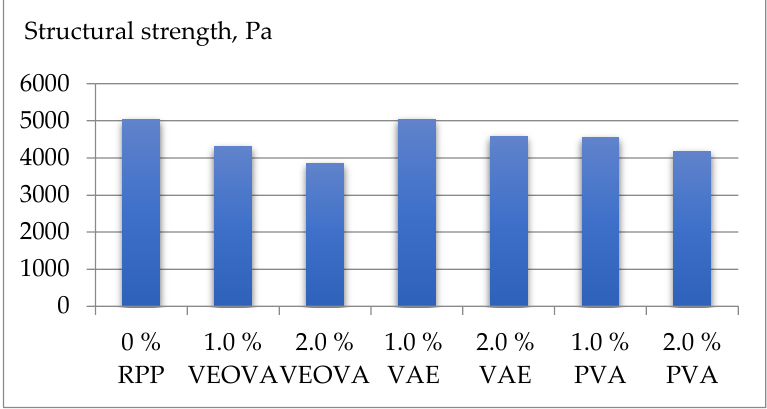
Figure 5. Structural strength in 30 min after mixing mixtures using RPP. Polymer powders have mixed effects on both compressive and splitting strengths at addition of polymers of all types significantly reduces the tensile splitting strength and compressive strength at the early stages of curing. However, when approaching 28 days of age, RPPs have a positive effect on the studied parameters.